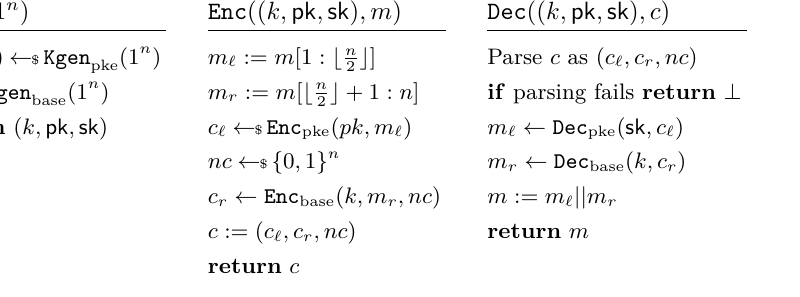
Figure 3: The symmetric encryption scheme SE : The plaintext m is split in two